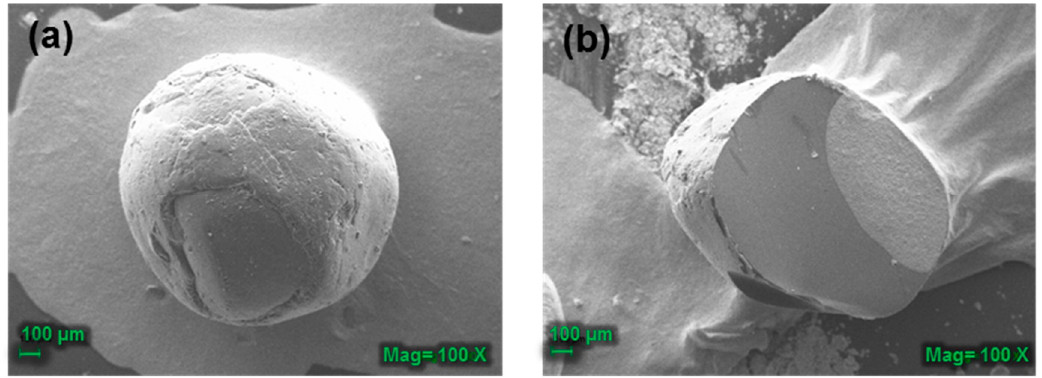
Figure 4. Scanning electron microscopy of ( a ) the surface area of a CB-TCEO and ( b ) the transversal cut area at 100×.